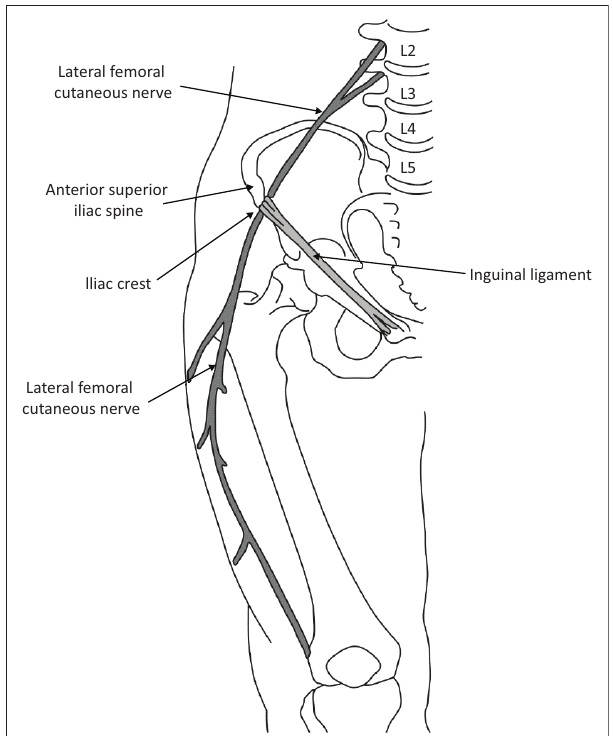
FIGURE 1: Diagram illustrating the anatomy of the lateral femoral cutaneous